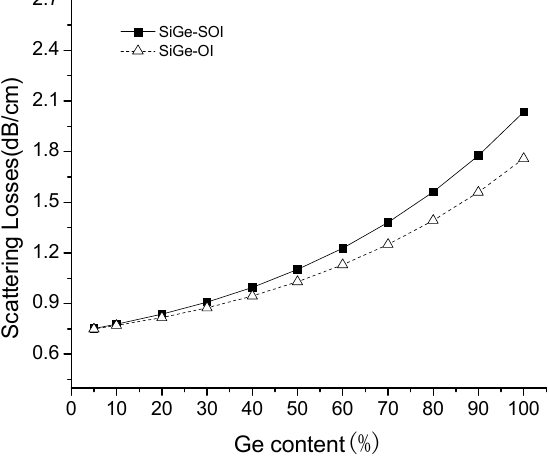
Figure 5. The relationship between scattering losses and Ge content at the wavelength of 1.55 μ m.